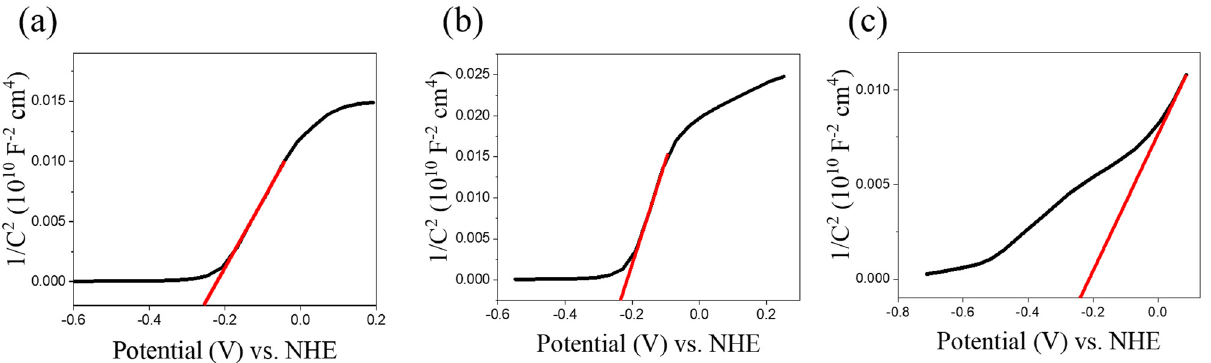
Figure 8: M – S plots of various Bi 2 S 3 products: ( a ) nanosheet, ( b ) nanoribbon, and ( c )